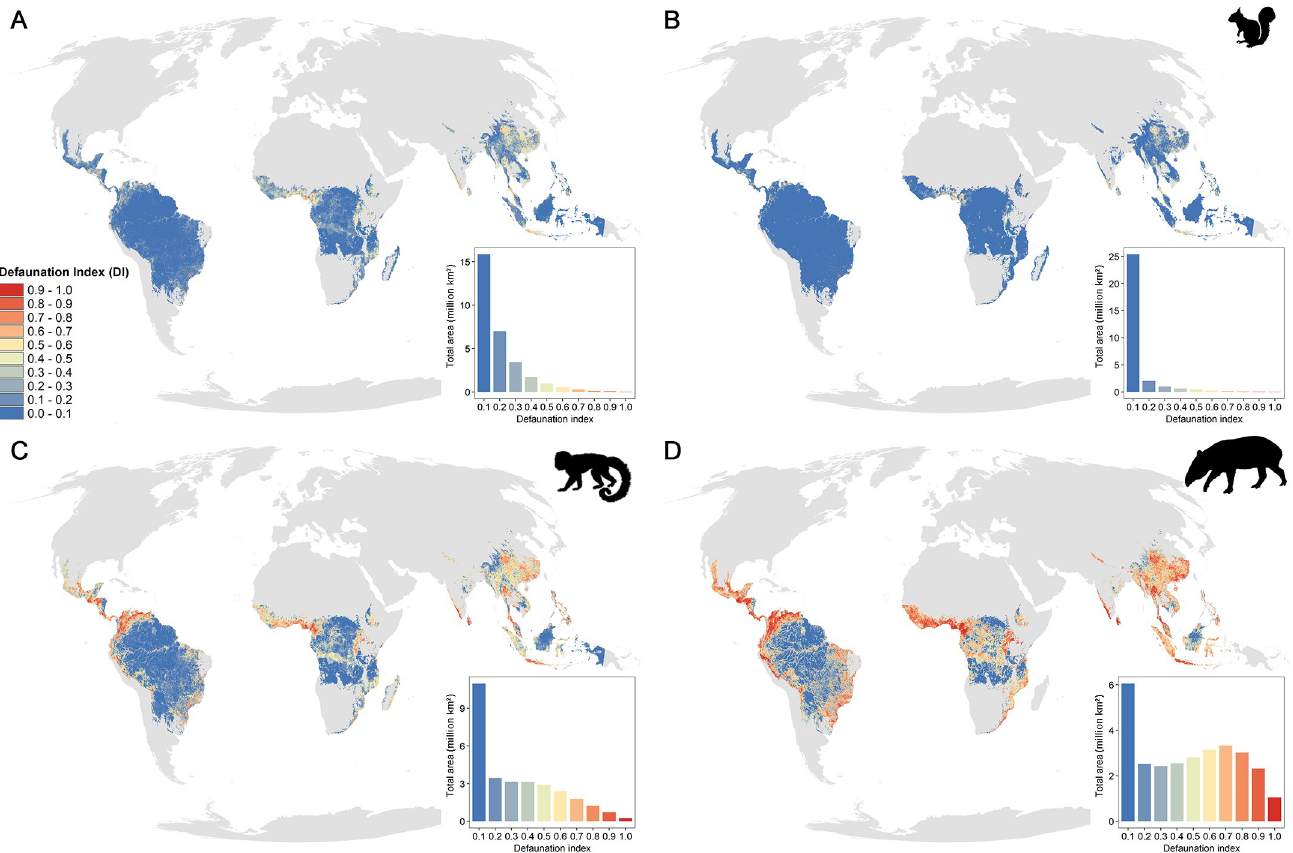
Fig 1. Geographic variation in hunting-induced defaunation for (A) all species, (B) small-sized species ( < 1 kg, e.g., Sciurus spp.), (C) medium-sized species (1–20 kg, e.g., Allouatta spp.), and (D) large-sized species ( > 20 kg, e.g., Tapirus spp.). The insets represent the total area (y-axis) under different levels of defaunation (x-axis, from DI = 0 [blue] to DI = 1 [red]). Note that the y-axes in the four insets have different scales. Available at https://figshare.com/projects/ Intact_but_emtpy_forests_Patterns_of_hunting-induced_mammal_defaunation_in_the_tropics/31118. DI, defaunation index.